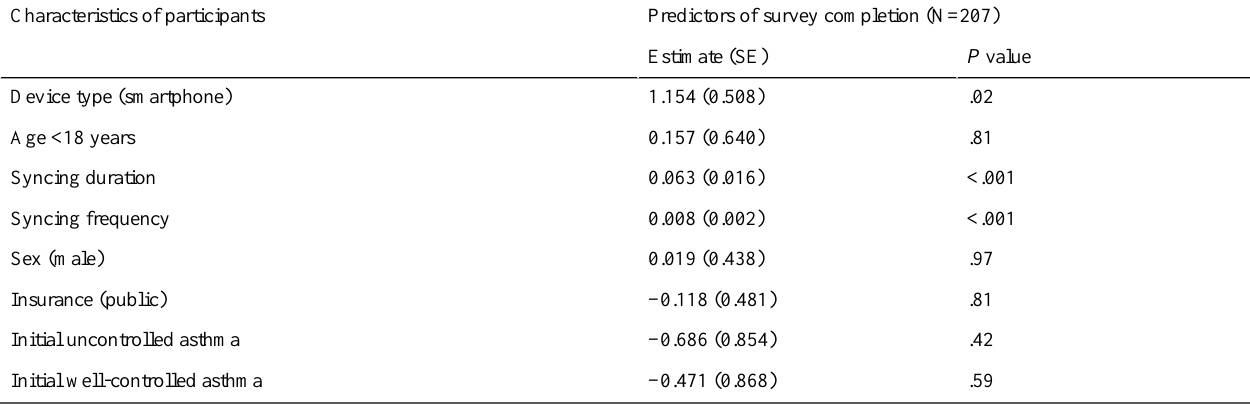
Table 2. Demographic and individual predictors of whether participants completed survey or not (N=207).